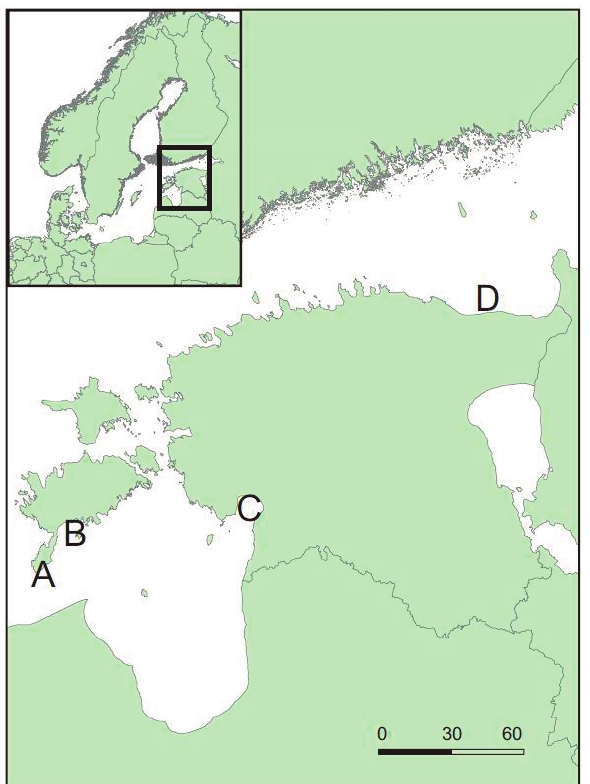
Fig. 1. The study